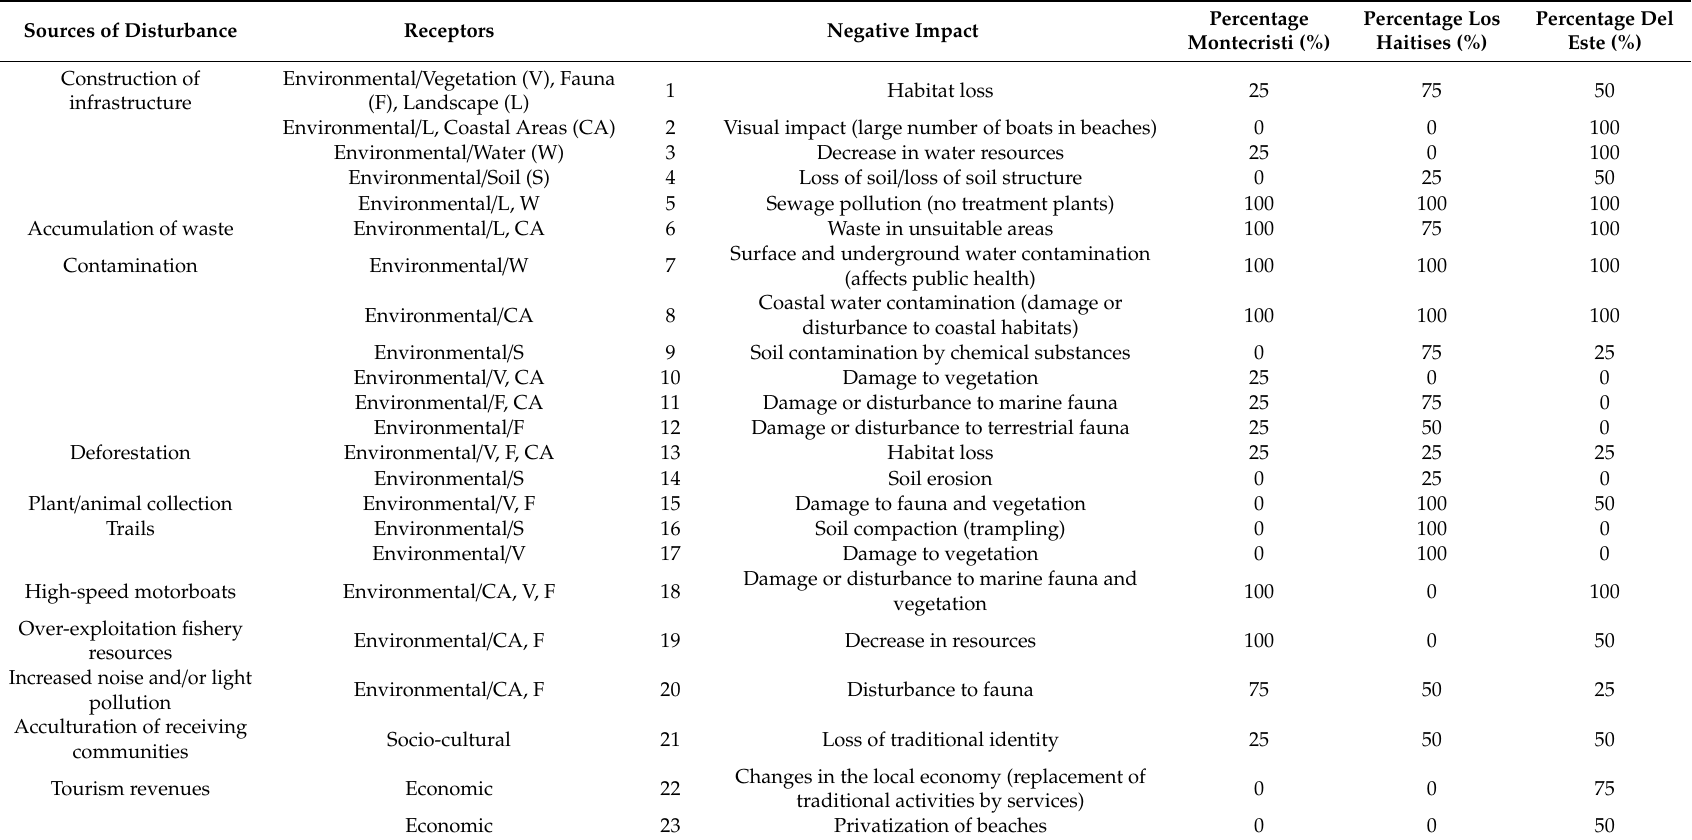
Table 5. Negative impacts perceived by the workshop participants in the National Parks. The sources of disturbance associated with tourism, the environmental, socio-cultural, and economic receptors potentially e ff ected, and the perceived negative impacts are shown. The percentage of participants who perceive the negative impact is indicated (the rest of the participants did not perceive the